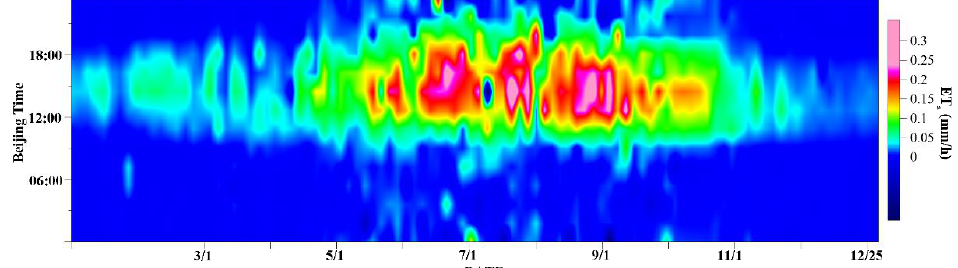
Figure 6. The annual distribution of evapotranspiration at the alpine swamp meadow during 2020. The different colors from blue to pink represent the actual evapotranspiration (ET a ) per half hour. The time between 6:00 and 18:00 represents daytime.